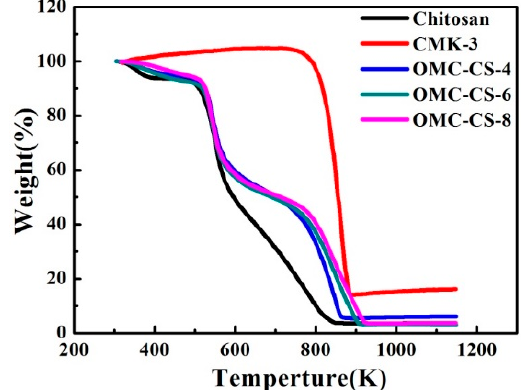
Figure 4. Thermogravimetric weight change curves under air atmosphere for chitosan, CMK-3, and OMC-4,6,8.